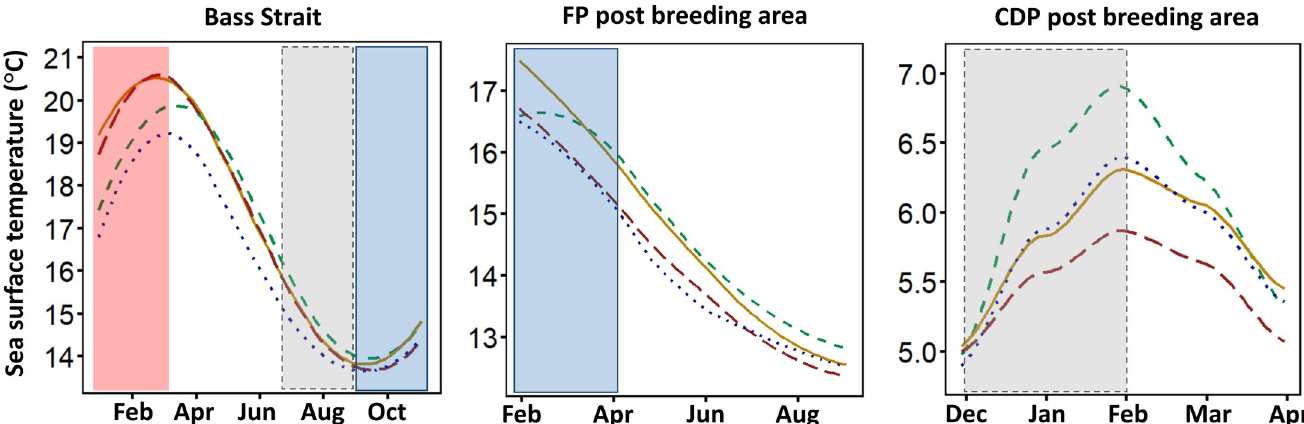
Fig 4. Inter-annual variation of sea surface temperature in three areas of importance to FP and CDP. The lines represent the conditions in the year preceding the 2017/18 breeding season (green dashed line); 2018/19 breeding season (orange line); 2019/20 breeding season (red dashed line); the 2020/21 breeding season (blue dotted line). Post-breeding migration area refers to the core area used by fairy prion and common diving petrels from Kanowna Island during their post-breeding migration (see Fig 1). Shaded columns refer to the period of time regarded as important for coastal krill (red; Bass Strait = December–February), FP (blue; Bass Strait early breeding = September–November; Post breeding area = mid-January–mid-March) and CDP (grey; Bass strait early breeding = July–September; Post breeding area = December–February).